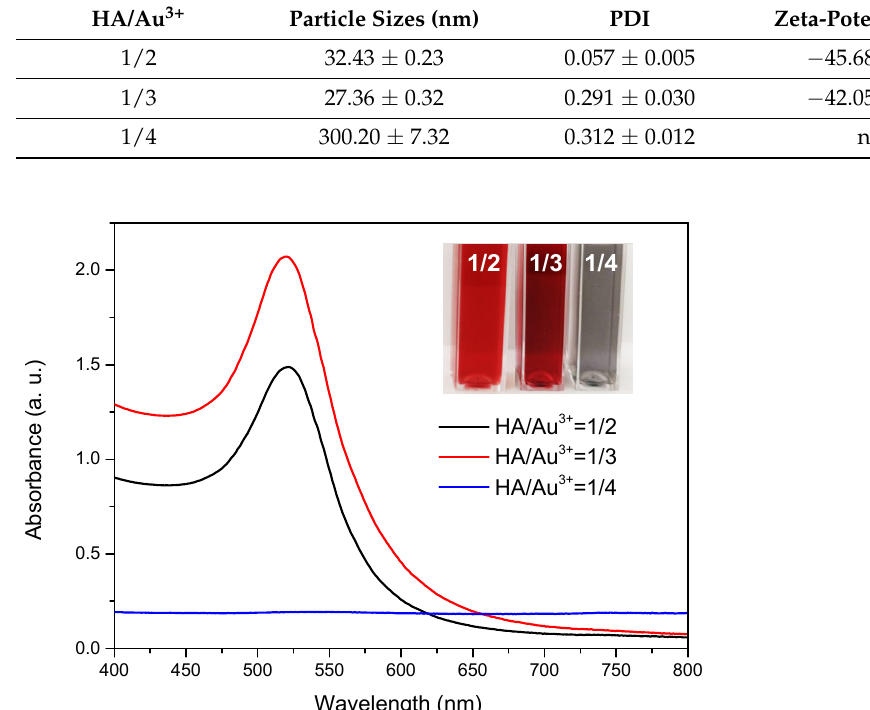
Figure 1. UV-vis spectra of HA-reduced AuNPs at specific HA to HAuCl 4 · 3H 2 O molar ratio, reflecting characteristic SPR peaks from AuNPs. Inset, images of different batches of AuNPs suspensions.